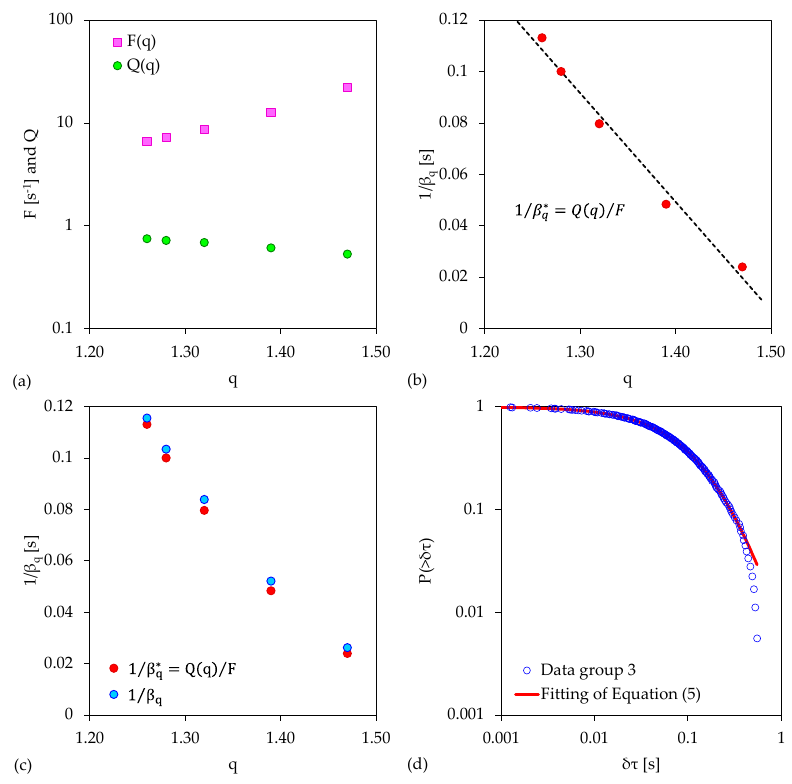
Figure 10. Regarding the UC loading protocol: ( a ) The variability of the values F ( q ) and Q ( q ) as functions of the index q . ( b ) The linear relationship of the index q and the parameter β q based on the relationship 1/ β ∗ q = Q ( q ) / F . ( c ) Comparison between the variability of 1/ β ∗ q and 1/ β q as functions of the index q . ( d ) The CDFs and the corresponding fitting for AE hit group